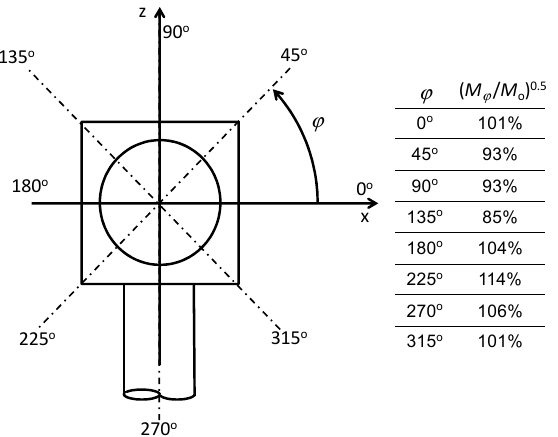
Figure 6. The symmetry check of the supply airflow from the multi-cone diffuser, partial momentum jet per 1/8 of the cylindrical cross-sectional area of the RWJ (cid:3435)𝑀 (cid:3101) /𝑀 (cid:3042) (cid:3439) . The results of the air speed measurement in RWJs from both diffusers at the airflow rate of 793 m 3 /h were used to adjust the calculation method of the air velocity. Measure- ment data from all cross-sections of tested jets was approximated using the Verhoff’s equation presented in [8] at the distance from the ceiling 0 < η w < 1.2: